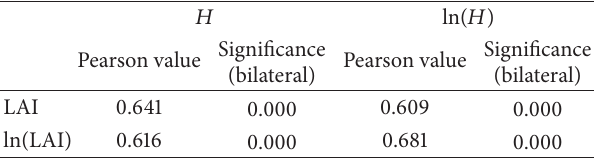
Table 3: Correlation matrix of 𝐻 , ln( 𝐻 ), LAI, and ln(LAI).